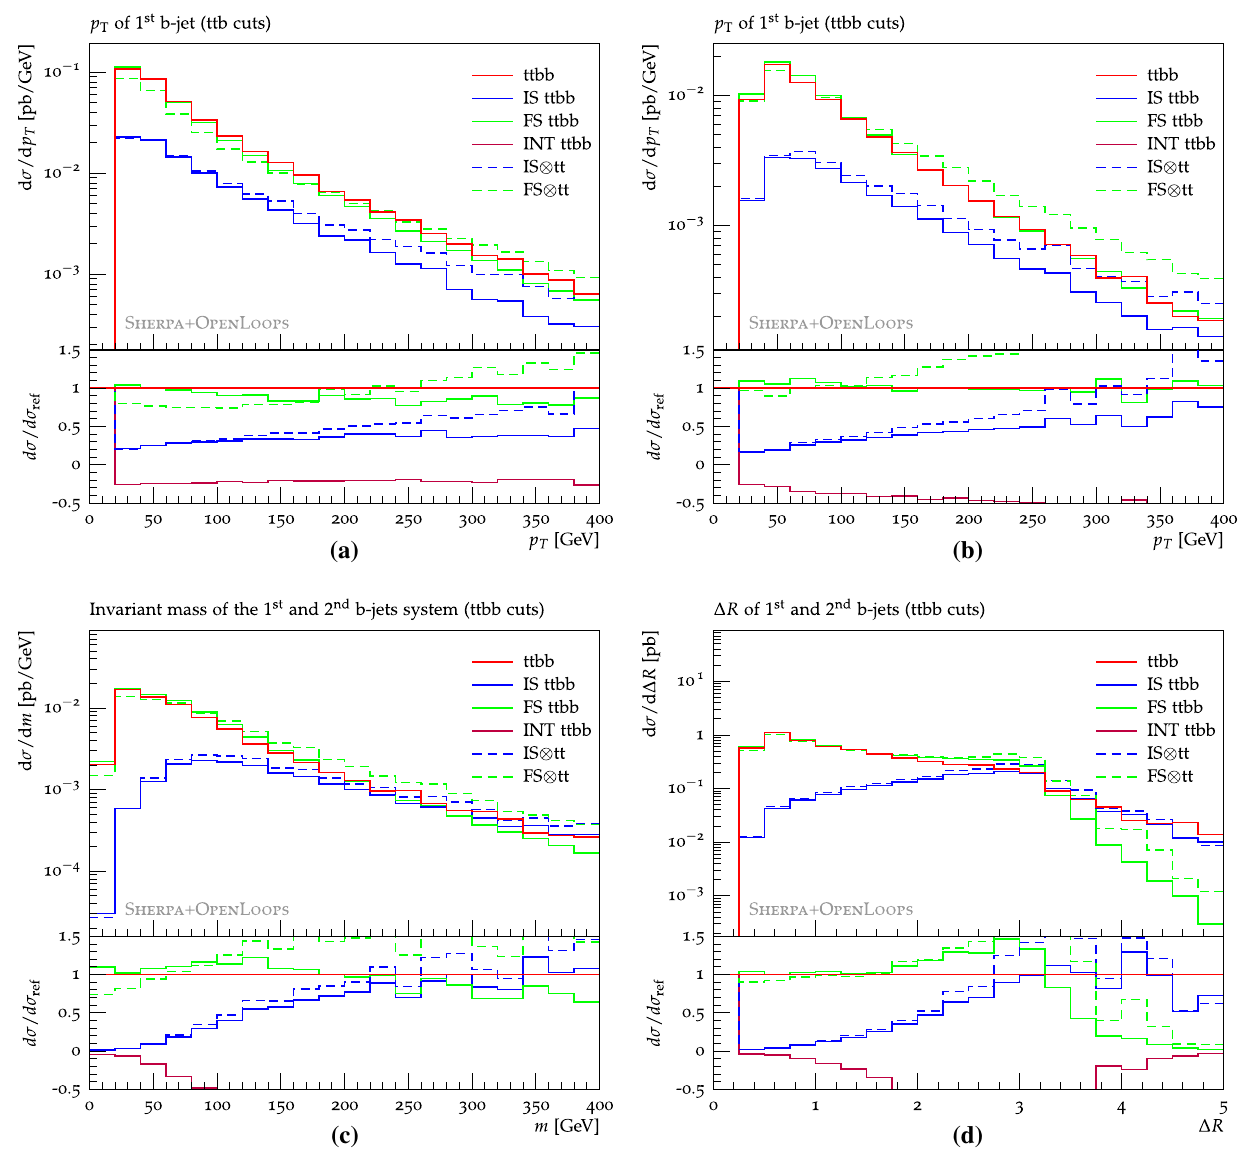
Fig. 6 Breakdown of the pp → t ¯ tb ¯ b cross section into contributions from topologies with IS and FS splittings at fixed-order LO in the 4F scheme: distributions in the p T of the leading b -jet with ttb ( a ) and ttbb ( b ) cuts, and distributions in the invariant mass ( c ) and Δ R separation ( d )ofthetwoleading b -jetswithttbbcuts.Thecomplete gg / q ¯ q → t ¯ tb ¯ b matrix-element prediction (solid red) is split according to (2) into con-